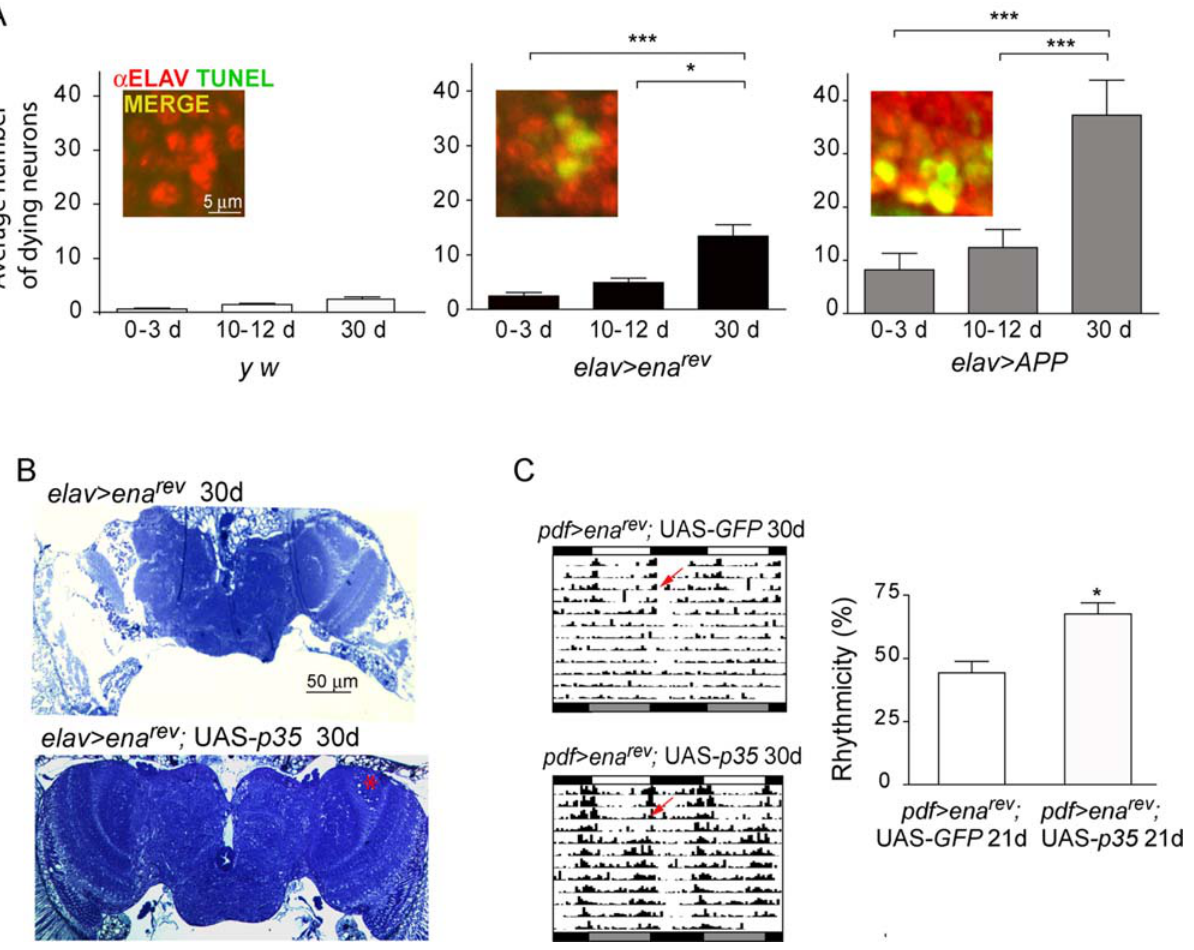
Figure 7. ena down-regulation correlates with progressive cell death. (A) Quantitative analysis of apoptotic cell death in adult brains of increasing age as indicated in the figure. A representative image of the extent of cell death in 30 day-old flies of the indicated genotypes is shown in the inset (upper corner, left). Twenty to fifty brain hemispheres were analyzed in each time point with exception of 30 day-old elav . APP (n=11). The degree of apoptosis in the affected individuals is significantly different from a wild type control (* p , 0.05, ** p , 0.001). (B–C) Degenerative phenotypes associated to ena rev are rescued by p35 expression. (B) Frontal sections at approximately the same depth of aged control and elav . ena rev , p35 brains highlight the extent of the morphological rescue. The asterisk denotes a region where small vacuoles can still be found in one of the few brains in which the rescue was not complete. (C) Functional rescue of ena- derived behavioral phenotypes. Representative actograms of old pdf . ena rev , p35 and control lines are included (left panel). The percentage of rhythmic individuals is also shown (right panel, * p , 0.05).